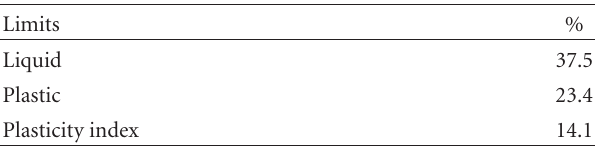
Table 3: Test of consistency limits of the soil sample.